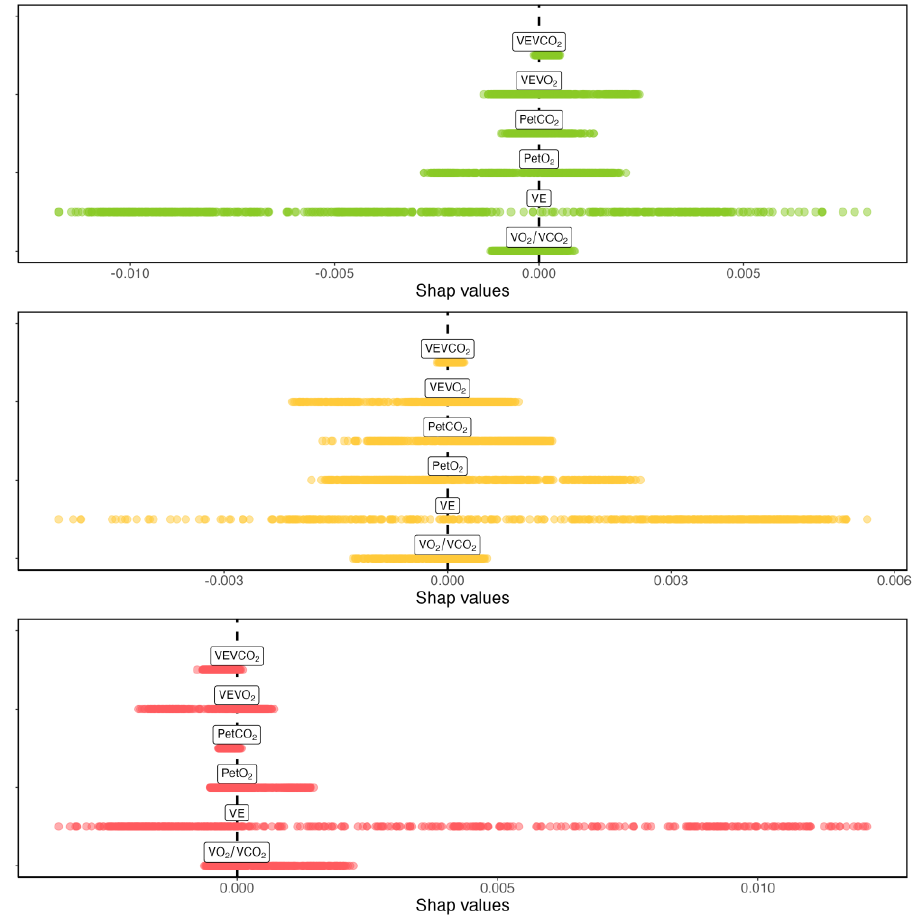
Figure 6. Comparison highlighting the magnitude of Shapley’s values for a representative individual and test. Colors are used to separate exercise intensity domains, i.e., moderate (green), heavy (yellow), and severe (red).